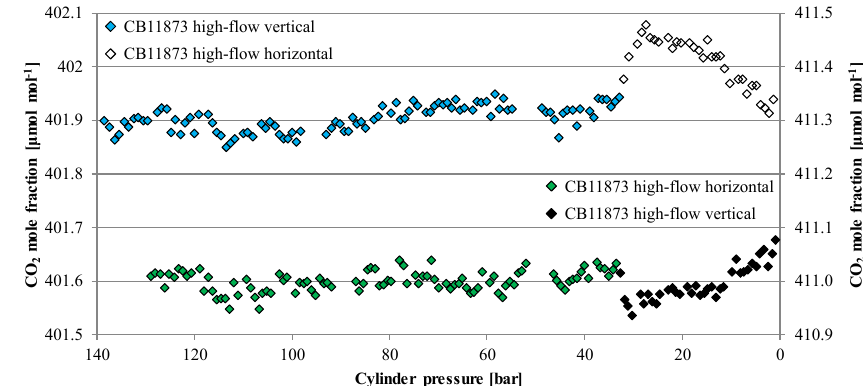
Figure 13. CO 2 mole fraction as a function of pressure; note the inverse x axis. The blue and empty diamonds belong to the primary y axis and were measured on CB11873 during a high-flow experiment, where the cylinder was first vertically positioned and then laid down at 32.1bar (indicated by the empty diamonds). The green and black diamonds belong to the secondary y axis and were measured on CB11976 during a high-flow experiment, where the cylinder was first horizontally positioned and then put up at 32.7bar (indicated by the black